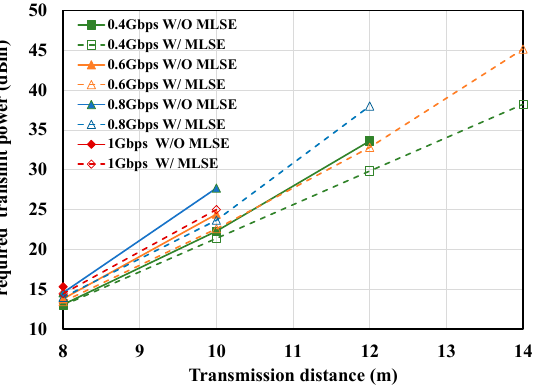
Figure 13. Required transmit power versus transmission distance with OOK modulation in harbor water with 30° FOV.